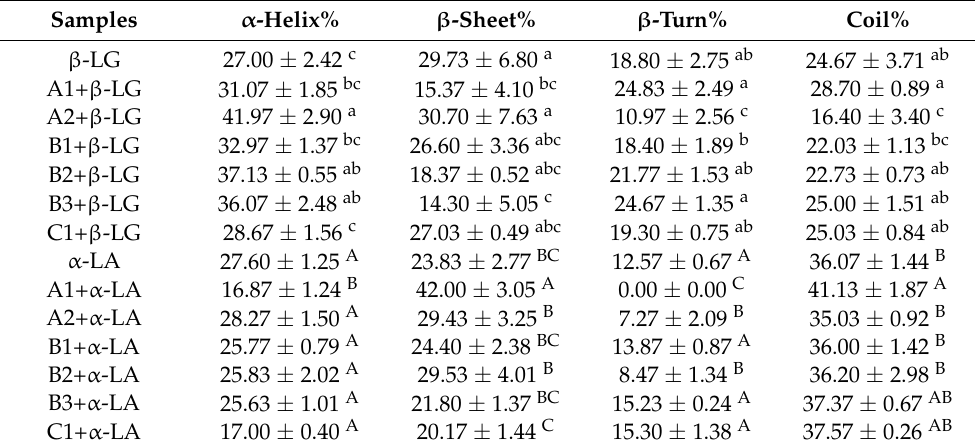
Table 4. Secondary structure analysis for β -LG/ α -LA and its complexes with A1, A2, B1, B2, B3, and C1 by the CD